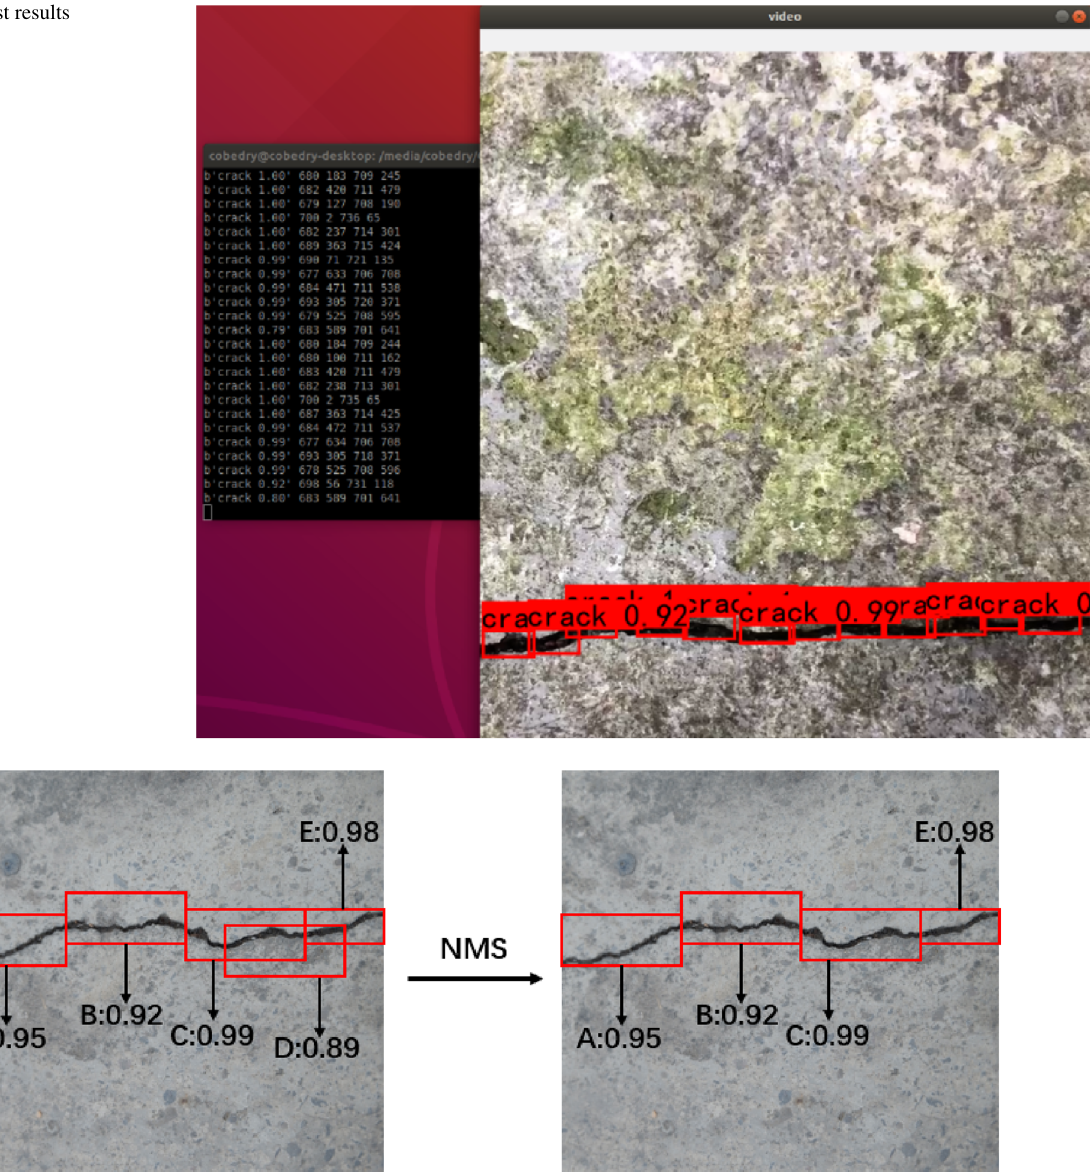
Fig. 11 Video test results